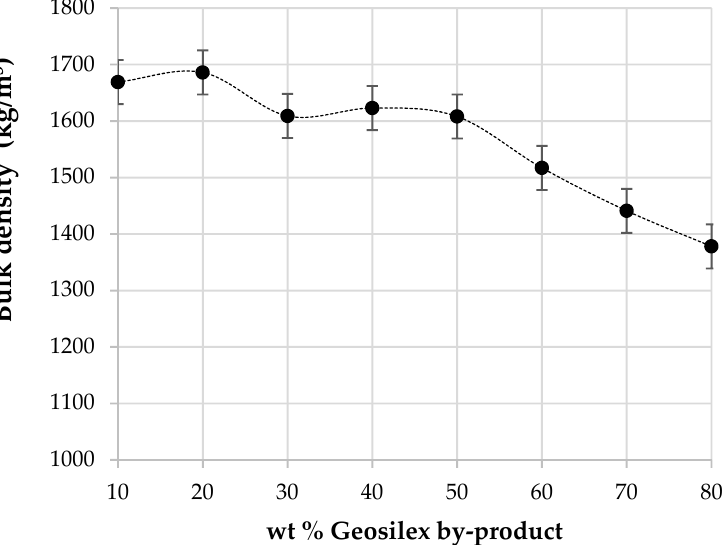
Figure 8. Bulk density of the xWBA ‐ yG calcium silicate units as function of G by ‐ product content.